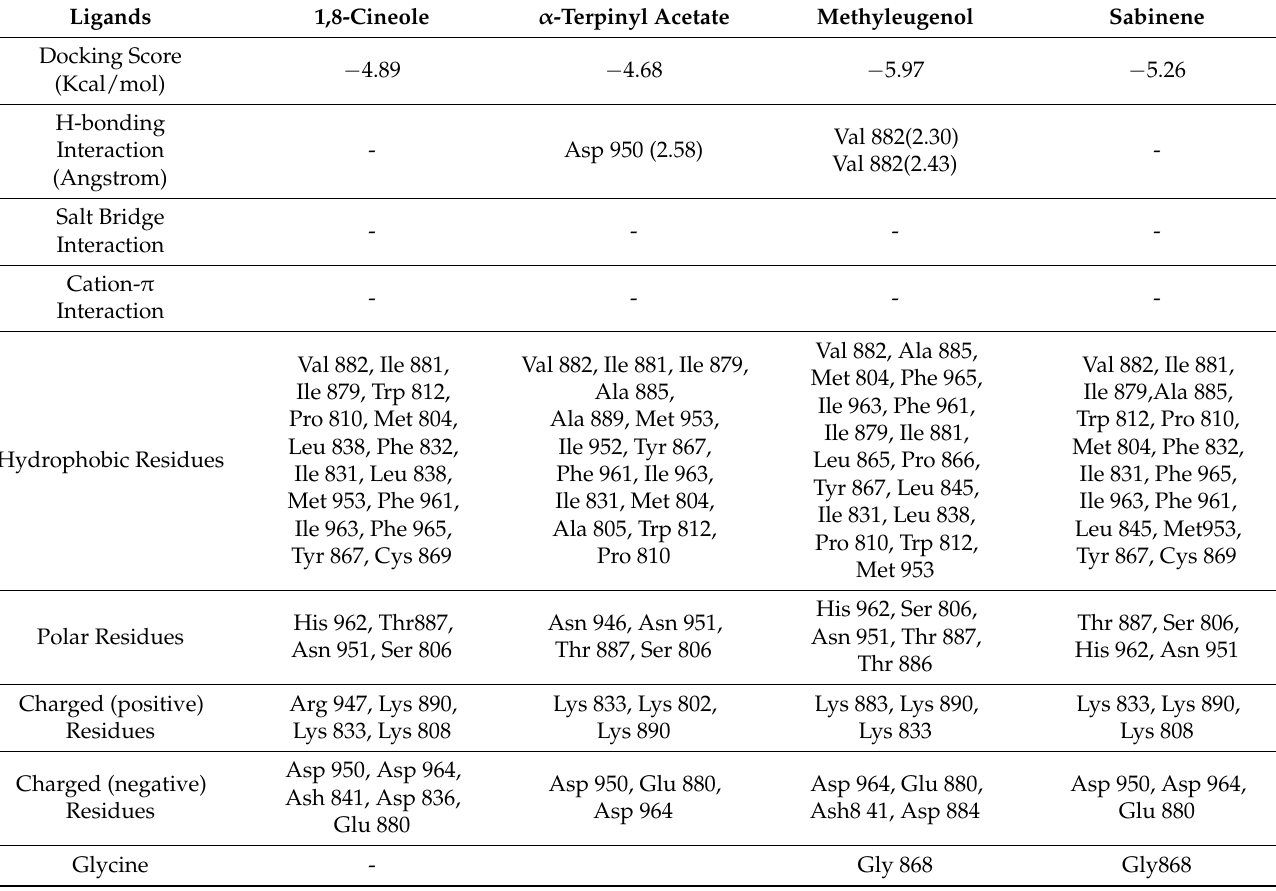
Table 2. The docking score energies and probable interactions of major ingredients of LNEO from Laurus nobilis L. with receptor as a potent inhibitor of PI3Ka and mTOR (PDB code: 4FA6).